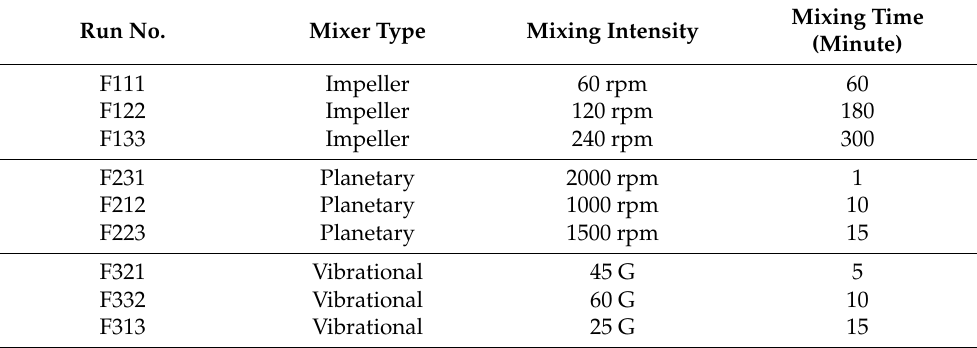
Table 2. Mixing processing parameters via Taguchi L9 orthogonal array design of experiment. Run